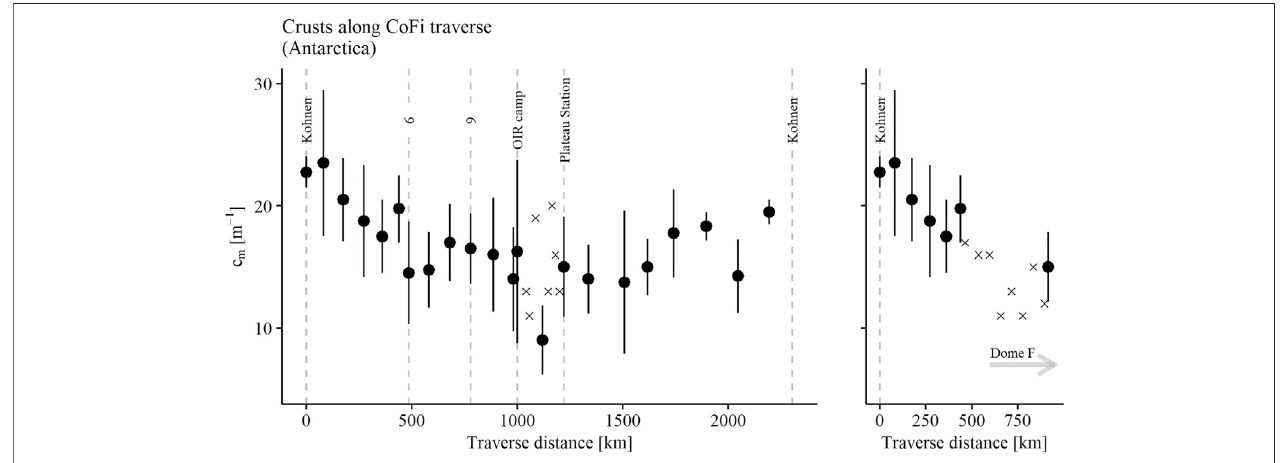
FIGURE 4 | Crust concentration in the uppermost meter along the CoFi traverse route. Solid dots represent the average c m per site with multiple pro fi les, small crosses show locations with only one snow pro fi le. Error bars in solid vertical lines show the standard deviation from multiple pro fi les at one sampling site.